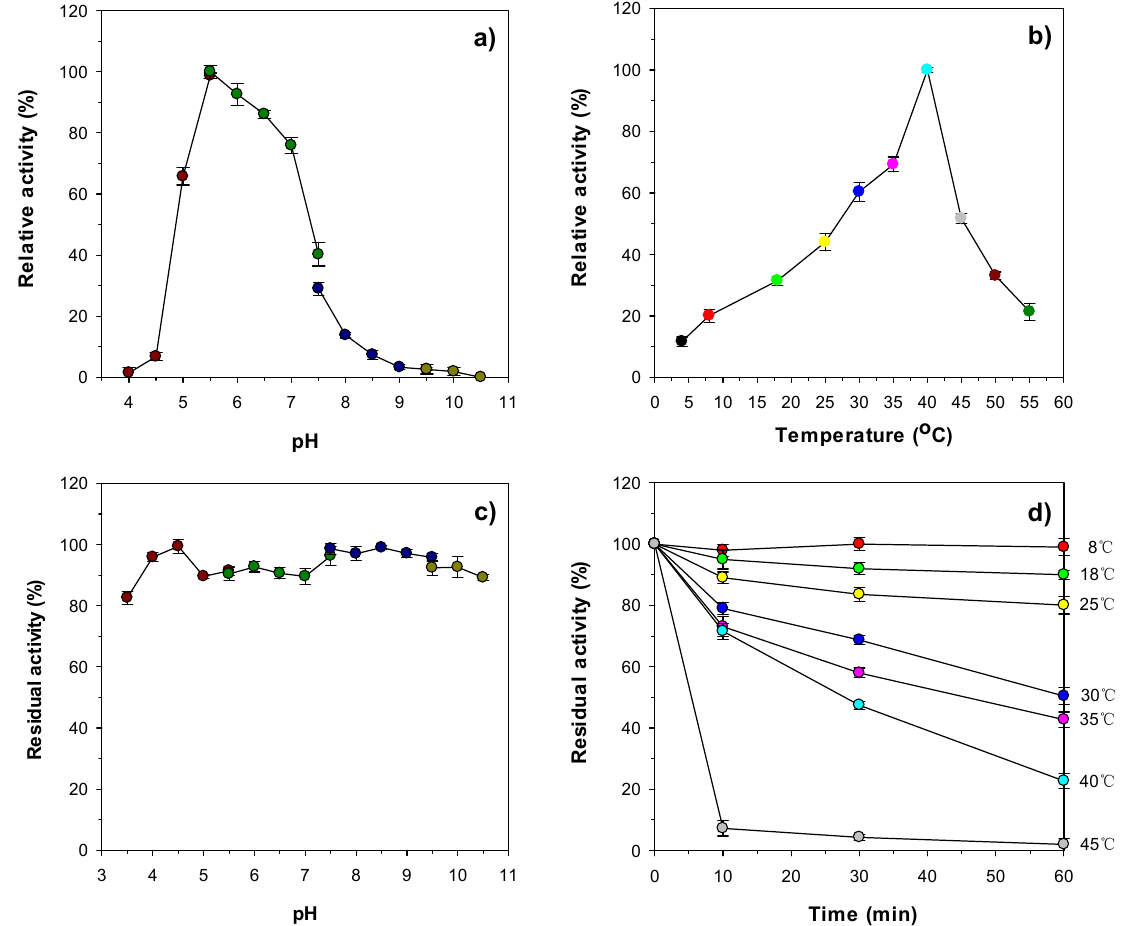
Figure 4. Effects of pH ( a ) and temperature ( b ) on the endo- β -1,4-xylanase activity of rXylR and effects of pH ( c ) and temperature ( d ) on the stability of rXylR. The optimal pH of rXylR was assessed using the following buffers (50 mM): sodium citrate (pH 4.0–5.5), sodium phosphate (pH 5.5–7.5), Tris-HCl (pH 7.5–9.5), and glycine-NaOH (pH 9.5–10.5). The optimum temperature of rXylM was determined at various temperatures (4–55 ◦ C) in 50 mM sodium phosphate buffer (pH 5.5). The residual endo- β -1,4-xylanase activities were evaluated at pH 4.0–10.5 after pre-incubation of rXylR using the following buffers (50 mM) at 4 ◦ C for 60 min: sodium citrate (pH 4.0–5.5), sodium phosphate (pH 5.5–7.5), Tris-HCl (pH 7.5–9.5), and glycine-NaOH (pH 9.5–10.5). The residual endo- β -1,4-xylanase activities were measured after pre-incubation of rXylR at 8, 18, 25, 30, 35, 40, and 45 ◦ C in 50 mM sodium phosphate buffer (pH 5.5) for 10, 30, and 60 min, respectively. The values are mean ± SD of triplicate